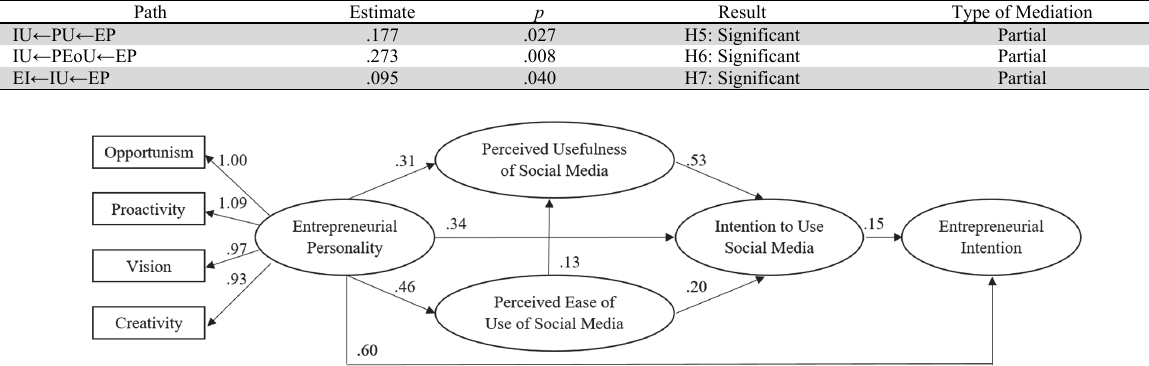
Fig. 2. Structural equation model (unstandardized